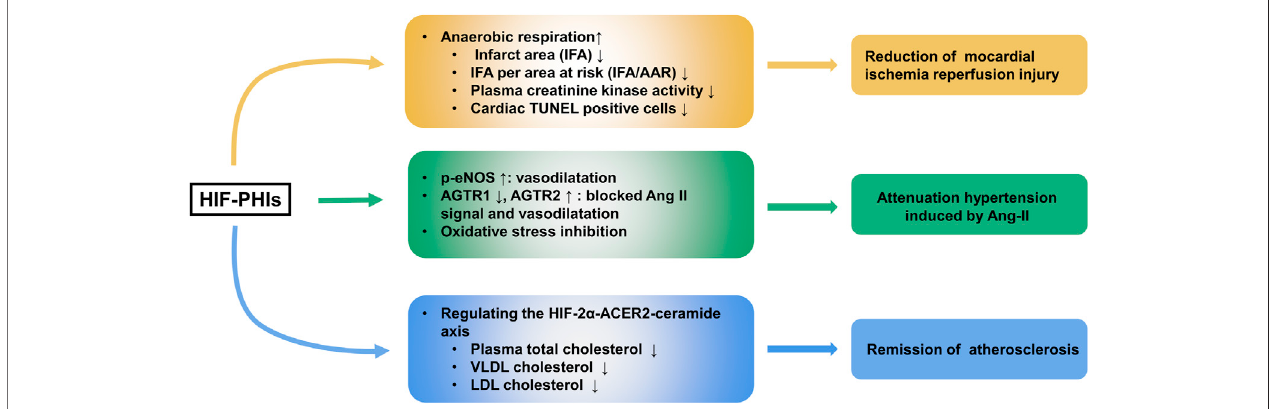
FIGURE 3 | Protective role of HIF-PHIs in cardiovascular diseases. HIF-PHIs can switch metabolism from aerobic to anaerobic respiration and produce ischemic tolerance,thusprotectingagainstischemicinjuryinheartdisease.Additionally,HIF-PHIscouldremarkablyameliorateAngIIinducedhypertension,possiblybystabilizing HIF-1 α and subsequently targeting eNOS, AGTR1, AGTR2, and oxidative stress, indicating that HIF-PHIs could be explored as a treatment for hypertension associated with high RAS activity or eNOS defects. Moreover, roxadustat was able to stabilize adipose HIF-2 α and intensify downstream ACER2-triggered ceramide catabolism. As ceramide is one of the atherogenic mediators, decreased ceramide resulted in decreased total cholesterol levels in plasma and decreased VLDL cholesterol and LDL cholesterol levels in adipocytes, indicating the potential usage of HIF-PHIs as an effective therapeutic strategy for treating atherosclerosis. HIF-2 α , hypoxia inducible factor 2 alpha; HIF-PHIs, HIF prolyl hydroxylase domain enzyme inhibitors; IFA, infarct area; IFA/AAR, IFA per area at risk; eNOS, endothelial nitric oxide; Ang II, angiotensin II; AGTR1, Ang II Receptor Type 1; AGTR2, Ang II Receptor Type 2; ACER2, alkaline ceramidase 2; VLDL, Very-low density lipoproteins; LDL, low density